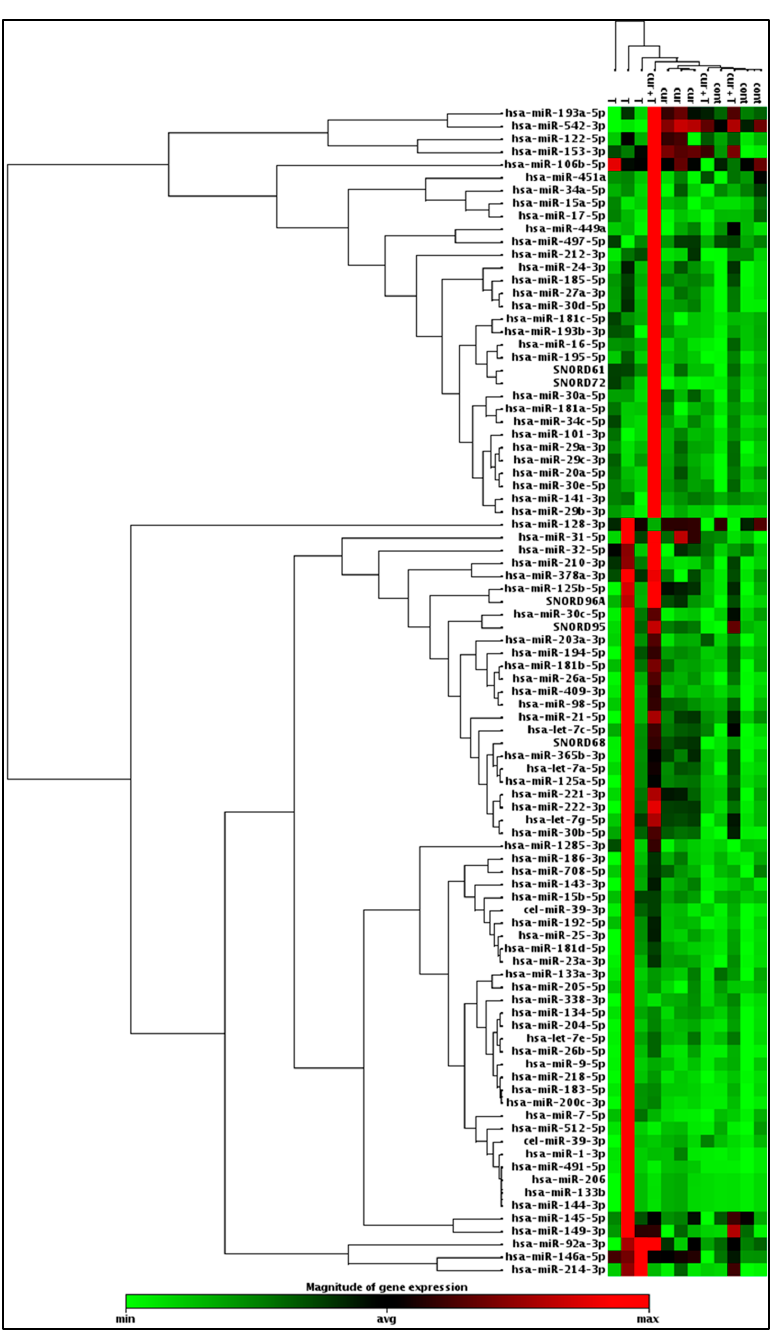
Figure 5. Hierarchical clustering analysis of miRNA microarray data. The heat map diagram shows the results of the two-way hierarchical clustering analysis of 84 apoptosis-regulating miRNAs after targeting ACHN cells with curcumin (cur), TRAIL (t) and TRAIL and curcumin (cur + T). The color scale illustrates the relative expression level of miRNAs ranging from high (red) to low (green) relative expression.